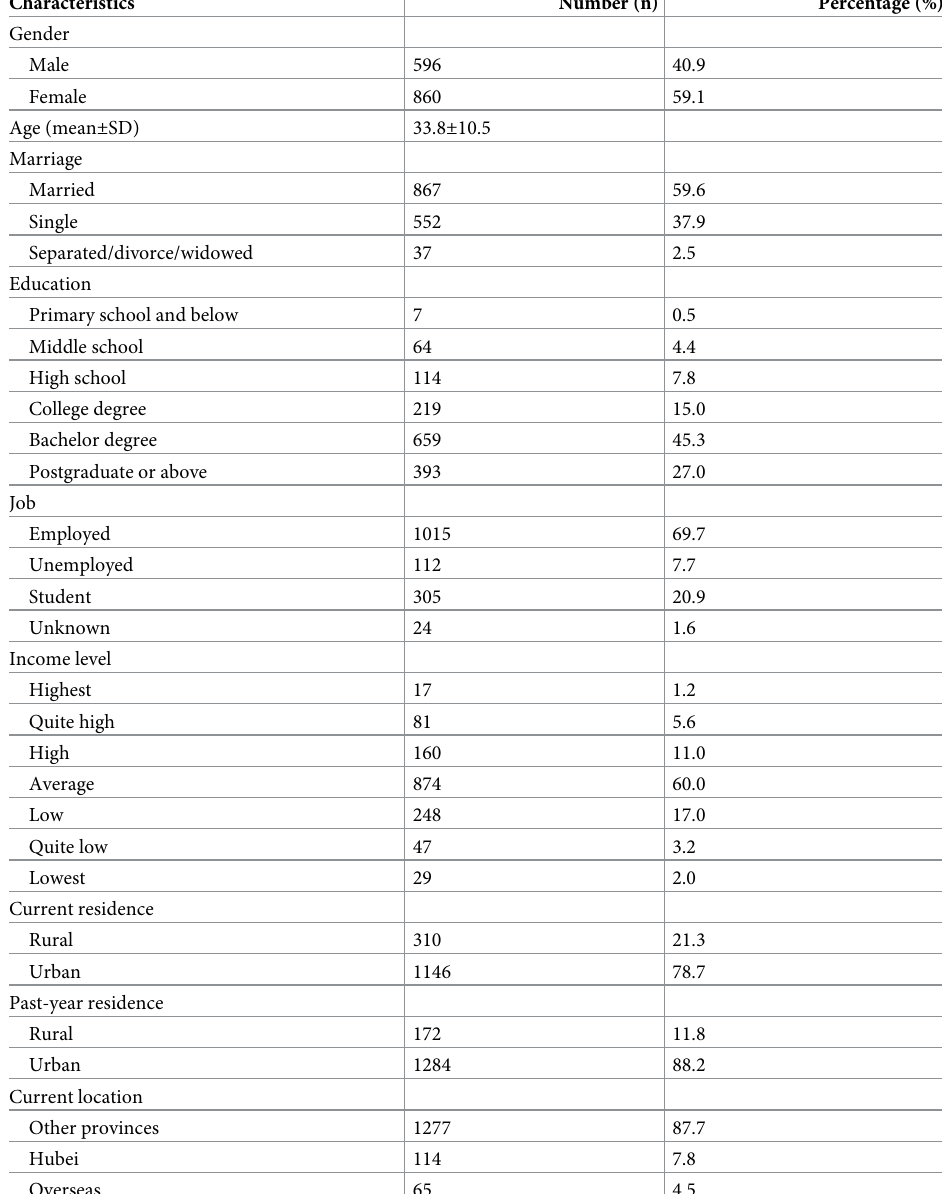
Table 1. Baseline characteristics (n =